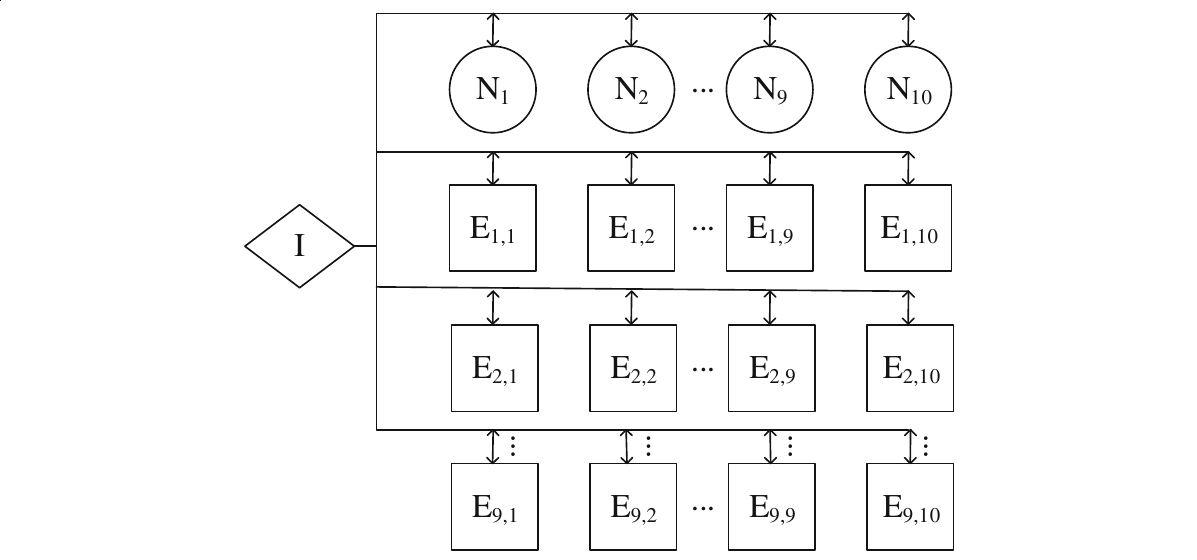
Fig. 5 Parallel Gauss-Jordan eliminator with matrix size 9 × 9